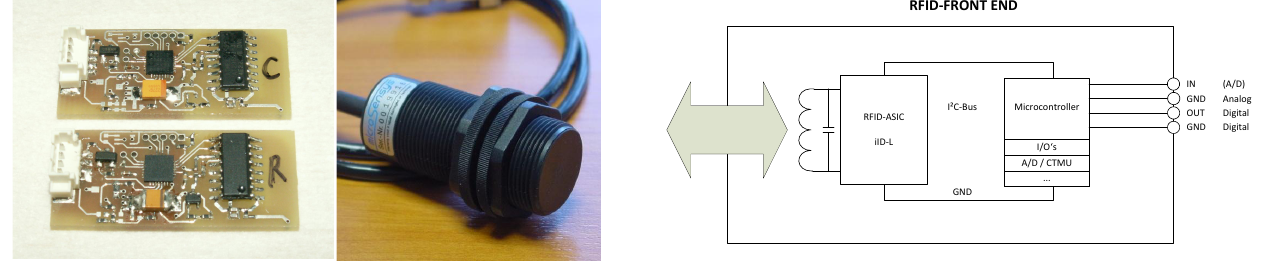
Figure 11. RFID-evaluation boards with front end controller for resistive and capacitive readout (left) and the used M30-Head for connection via USB to a processing unit (right).